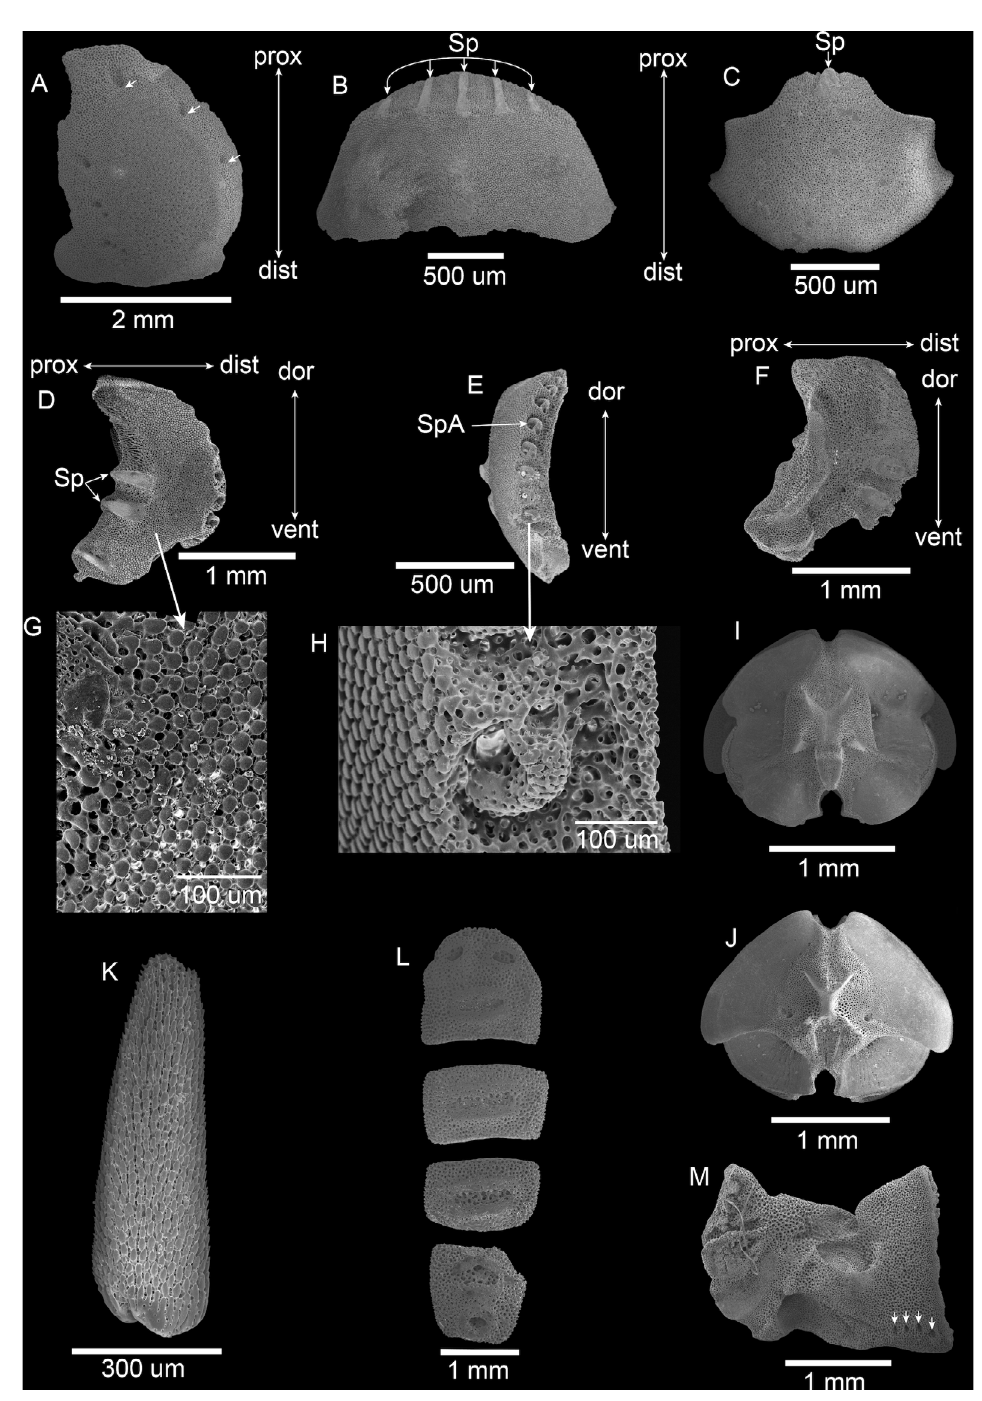
Fig. 9. SEM images of skeletal elements of Ophioderma variegatum (ICML-UNAM 3.20.4, DD = 13.6 mm). A . Radial shield (external view), deepest pores marked with arrows. B . Dorsal arm plate, with five spurs. C . Ventral arm plate, with one spur. D . Lateral arm plate, external face, with two spurs and one condyle. E . Lateral arm plate, lateral face, with spine articulations. F . Lateral arm plate, internal face. G . Outer surface of the LAP (D) with fine mesh and rounded knobs. H . Spine articulations with a weak sigmoidal fold and tilted lobes. I . Arm vertebra, distal face. J . Arm vertebra, proximal face. K . Arm spine. L . Dental plate fragments. M . Oral plate, adradial face, with arrows pointing to four oral papillae